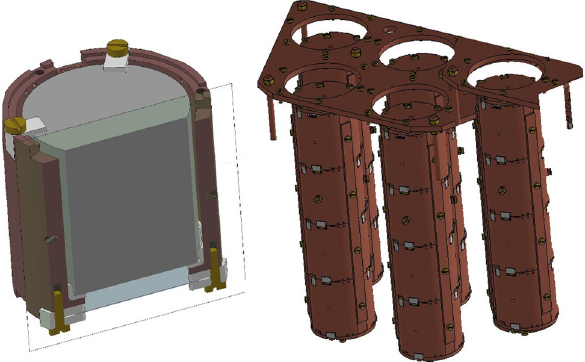
Fig. 1 Rendering of a CUPID-Mo single detector module (left) designed to hold a Li 2100 MoO 4 scintillating element. A module is comprised of a crystal of size (cid:4) 44 × 45 mm and a Ge wafer of (cid:4) 44 × 0 . 175 mm. The full 20-detector bolometric array is arranged in five suspended towers containing four detector modules each